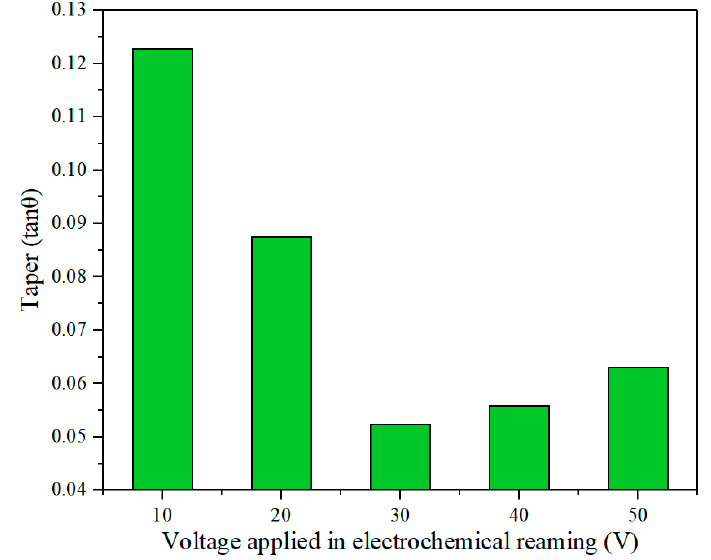
Figure 13. E ff ect of applied voltage on hole taper in electrochemical Figure 13. Effect of applied voltage on hole taper in electrochemical reaming.